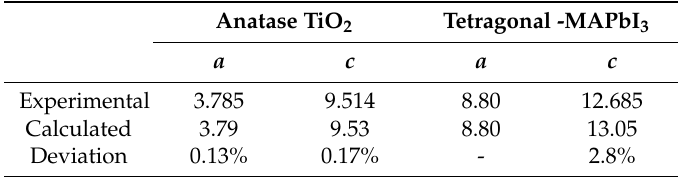
Table 1. Calculated lattice parameters of TiO 2 and MAPbI 3 and deviation between experiment and simulation.